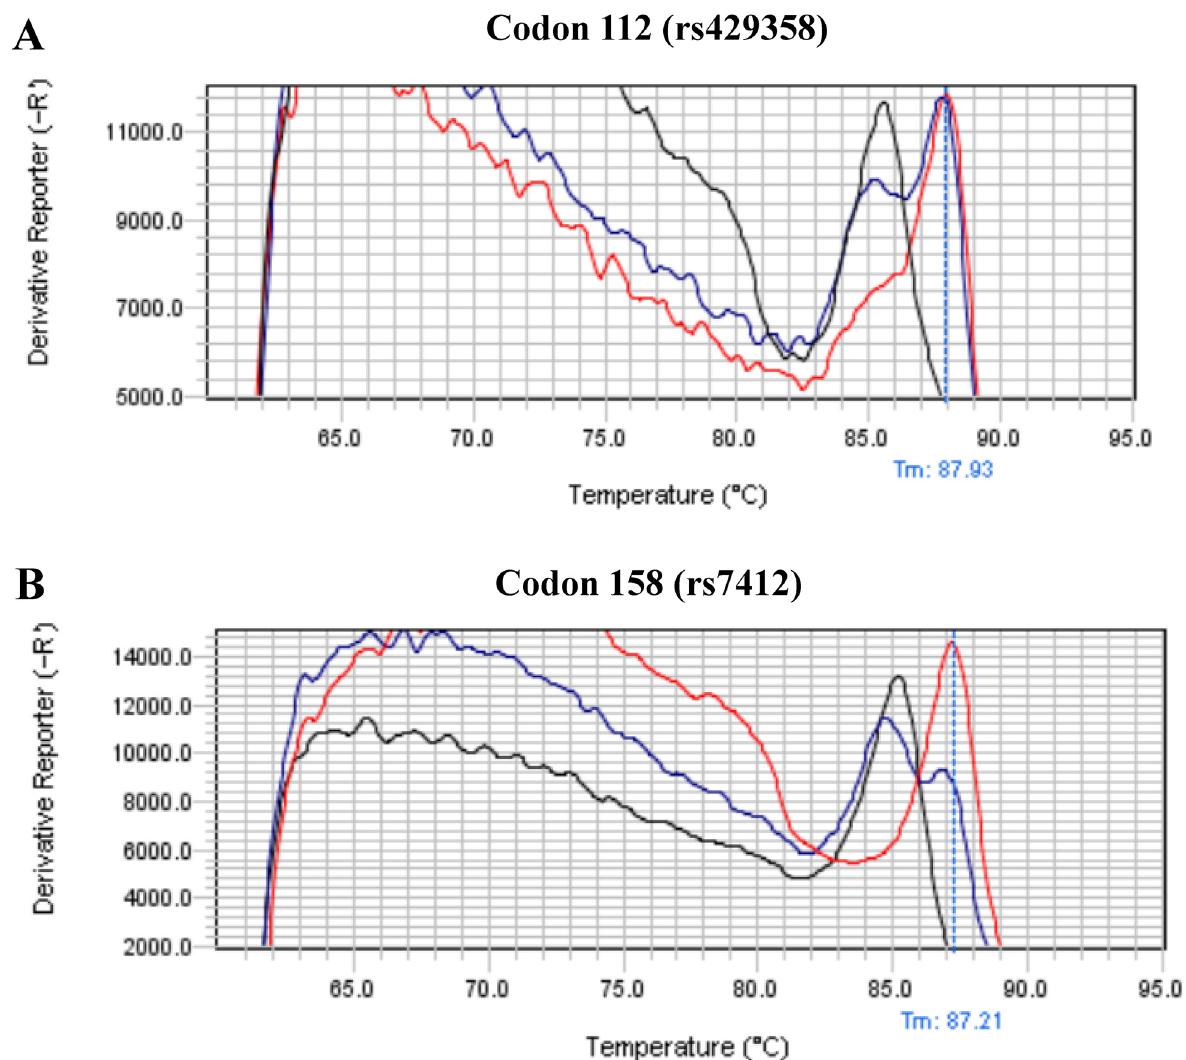
Fig 1. (A) Representative melting curve-based genotyping of rs429358 at codon 112 of APOE. Black color indicates TT homozygote; red color indicates CC homozygote while blue color indicates TC heterozygote. (B) Representative melting curve-based genotyping of rs7412 at codon 158 of APOE. Black color indicates TT homozygote; red color indicates CC homozygote while blue color indicates TC